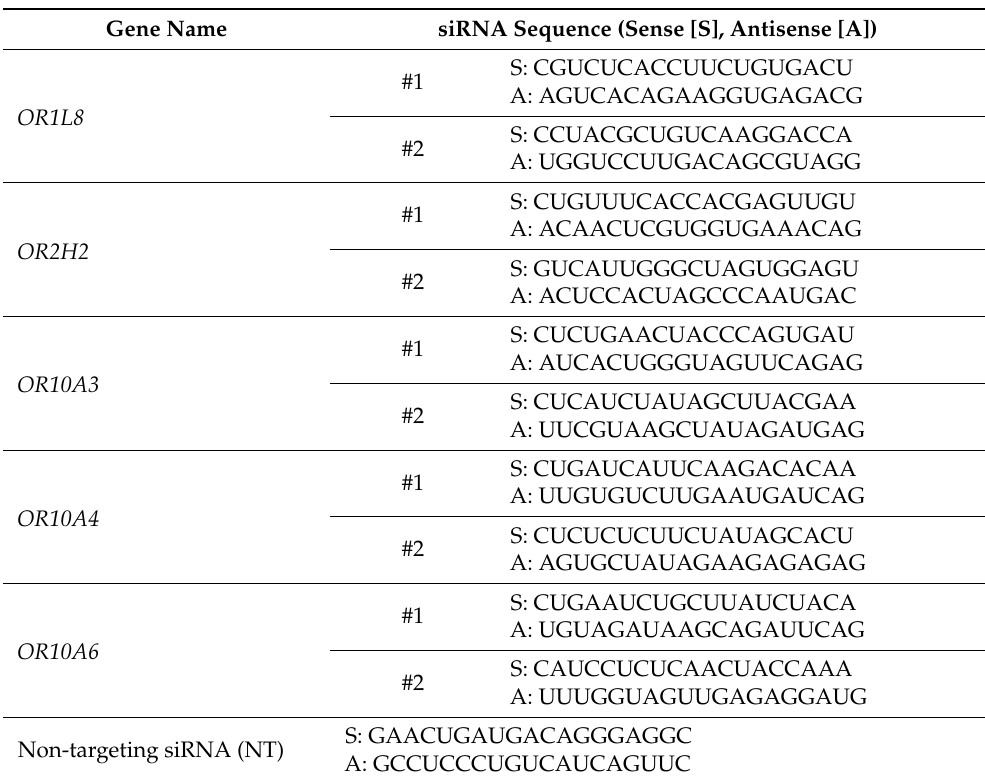
Table 2. siRNA sequences used for gene